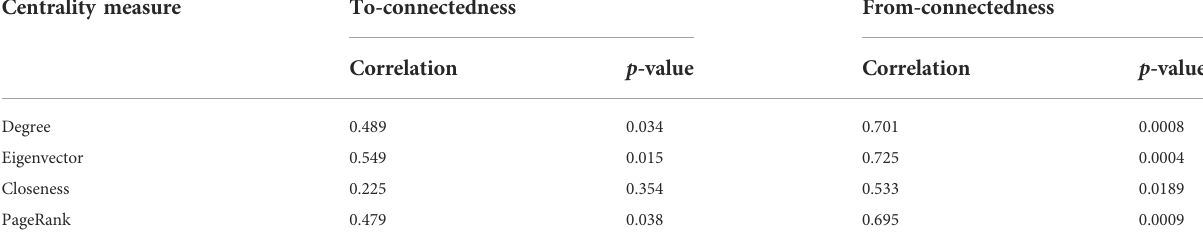
TABLE 1 Pearson correlation coef fi cients between the centrality measures in the DCCA network and spillover effects, as measured by to- connectedness C to i and from-connectedness C from i ,